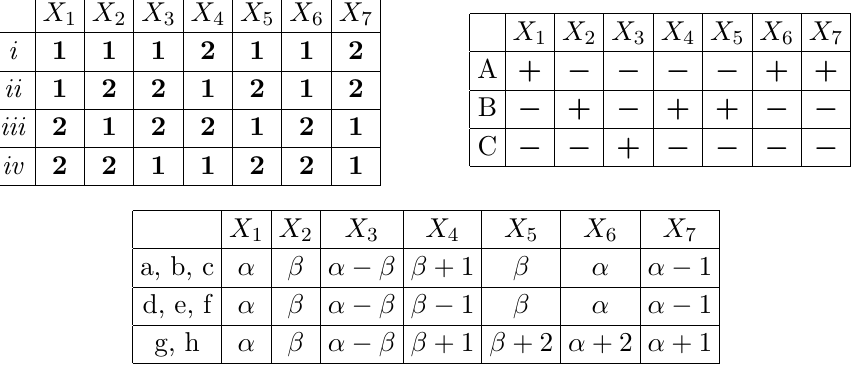
Table 1. SU ( 2 ) L (upper left), Z 2 (upper right) and U ( 1 ) Y (bottom) assignments for particles X 1 to X 7 of Class 1.a{1.h in (cid:12)gure